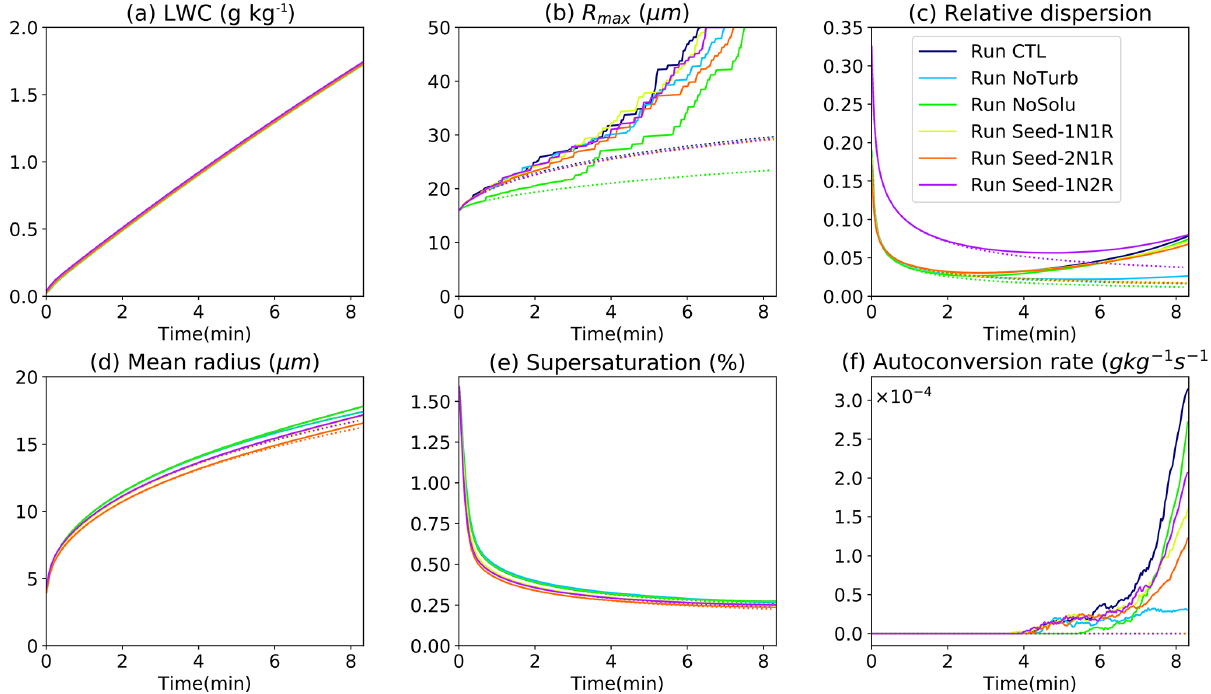
Figure 7. The temporal variation of bulk (a) liquid water content (LWC), (b) maximum droplet radius ( R max ), (c) relative dispersion, (d) droplet mean radius, (e) supersaturation ratio, and (f) autoconversion rate in the condensation–collision set of experiments (solid lines) and in the condensation-only set of experiments (dotted lines). The relative dispersion is defined as the standard deviation of the droplet radius divided by the mean radius. The autoconversion rate here is defined as the mass transfer rate from droplets smaller than R = 30µm to droplets larger than 30µm. The droplets over 50µm in size are treated as fallouts and removed from the domain. Thus (b) only shows a maximum droplet size at